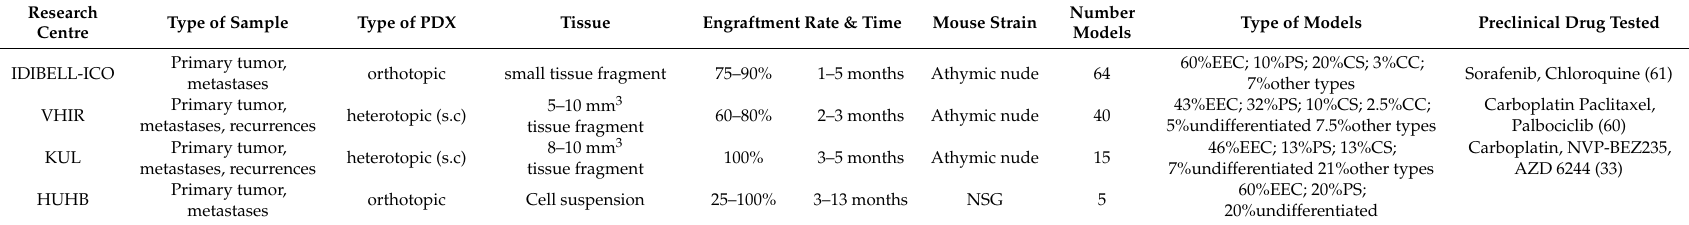
Table 1. PDX models developed by European Network of Individual Treatment in Endometrial Cancer (ENITEC) consortium